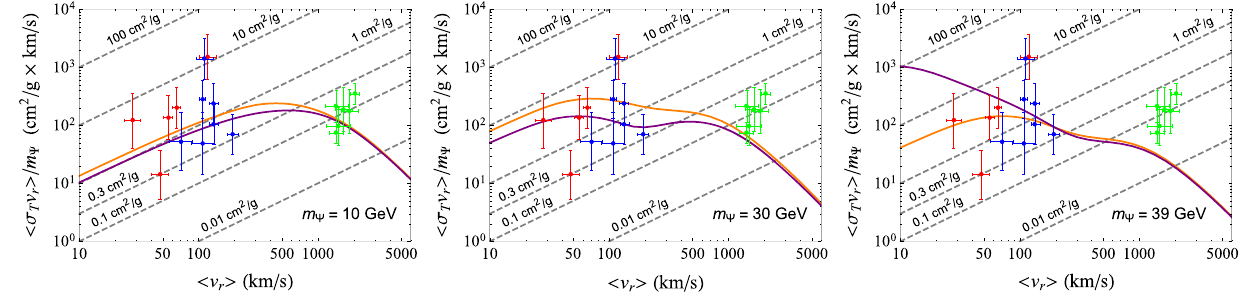
v (cid:11) / m (cid:3) T r